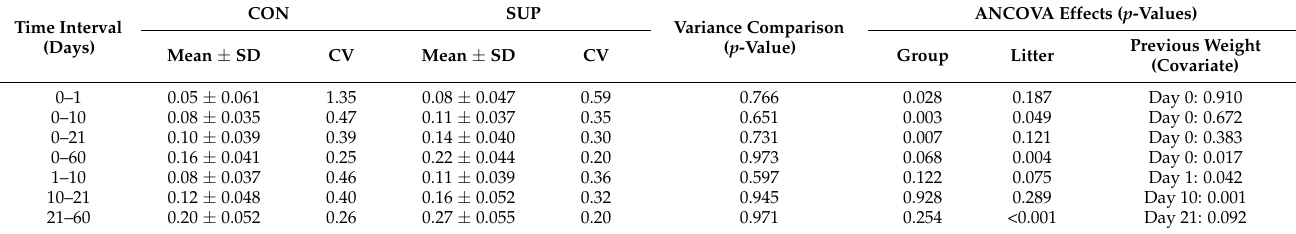
Table 5. Average daily gain (ADG: kgd − 1 ) for survivor piglets under Q1 (1.100 kg) birth weight for several time intervals from the CON ( n = 30) and SUP ( n = 35) groups. SD: Standard deviation. CV: Coefficient of variation. CON: control group; SUP: colostrum supplemented